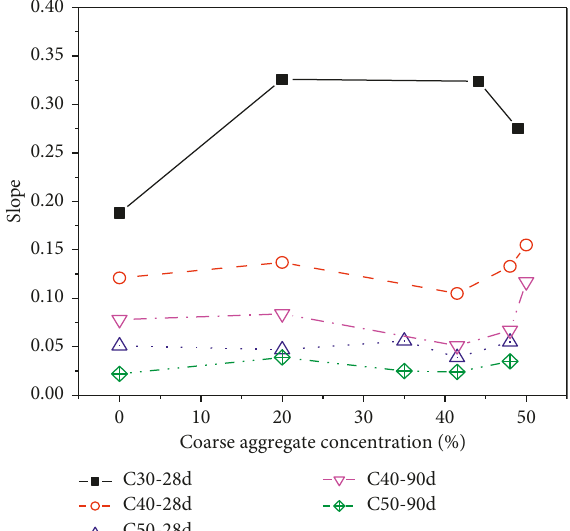
Figure 7: Relationship between scaling rate and coarse aggregate